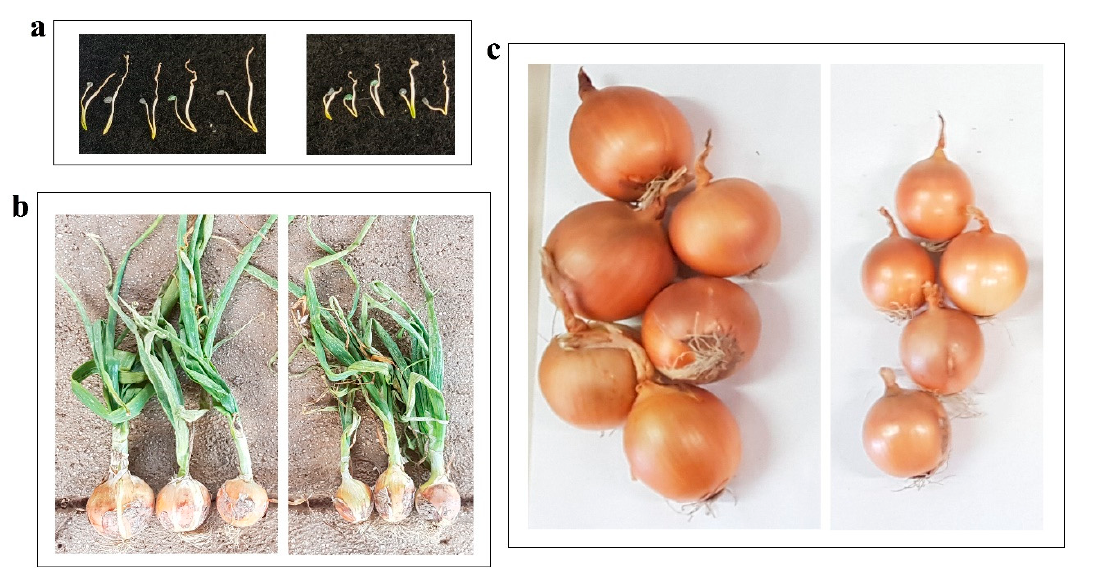
Figure 2. ( a ) Seedling, ( b ) plants, and ( c ) bulbs of Allium cepa. In the panels, inoculated plants are on the left, while controls are on the